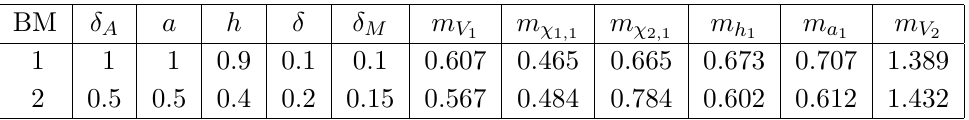
Table 2 . Parameters of the two Majorana DM BM models as discussed in the text; all masses are given in units of R (cid:0) 1